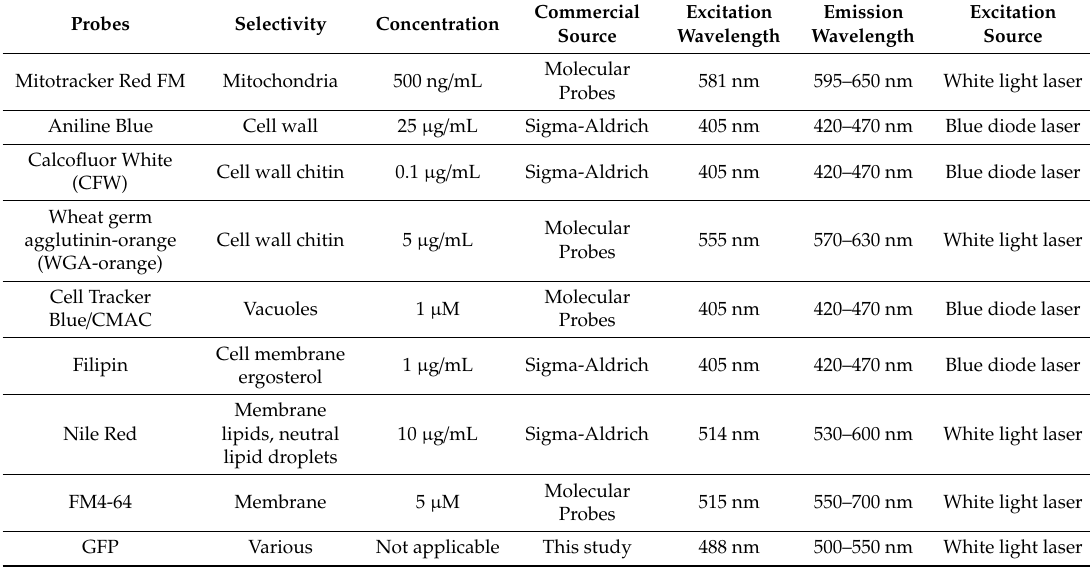
Table 1. Live-cell probes, their selectivities, concentrations used, commercial sources and confocal microscope imaging parameters